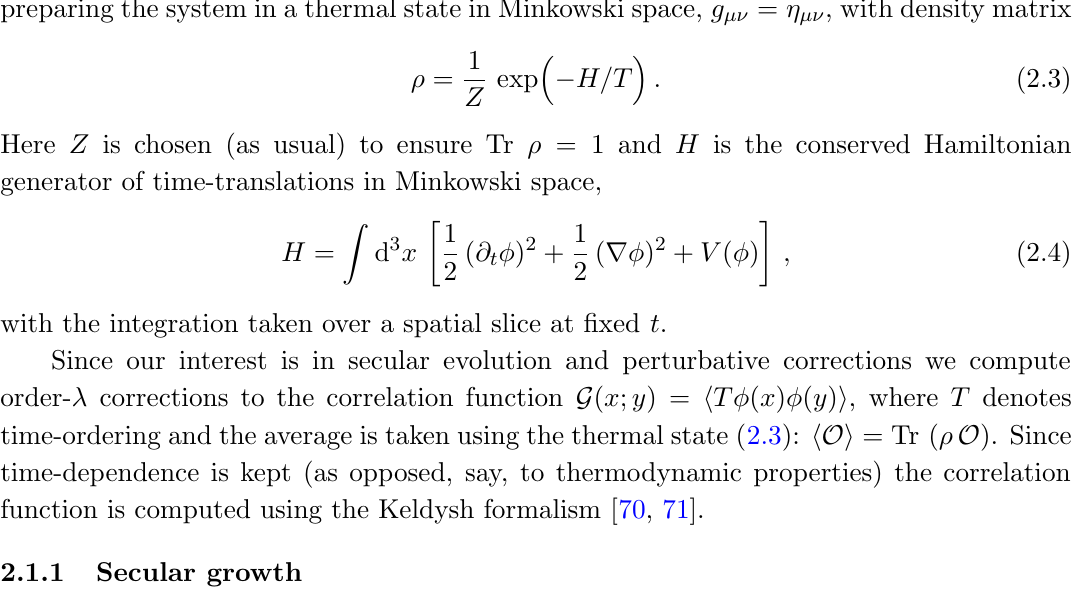
Figure 1 . Feynman graph giving the leading one-loop ‘tadpole’ correction to the scalar propagator. The result obtained by evaluating this graph must be summed with the tree-level two-point counter- term